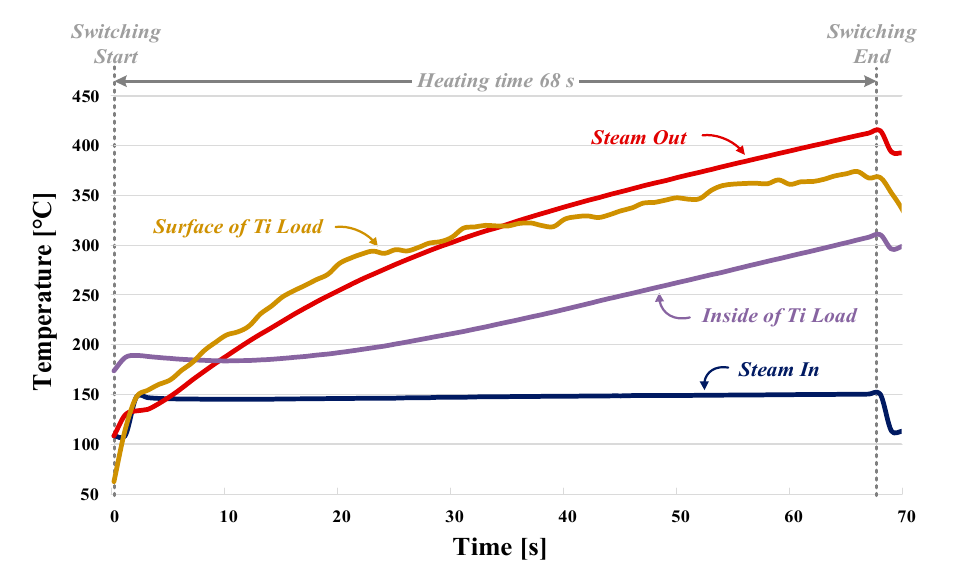
Figure 18. Temperature graph of the steam heating test. Table 4. Temperature results of the steam heating test.